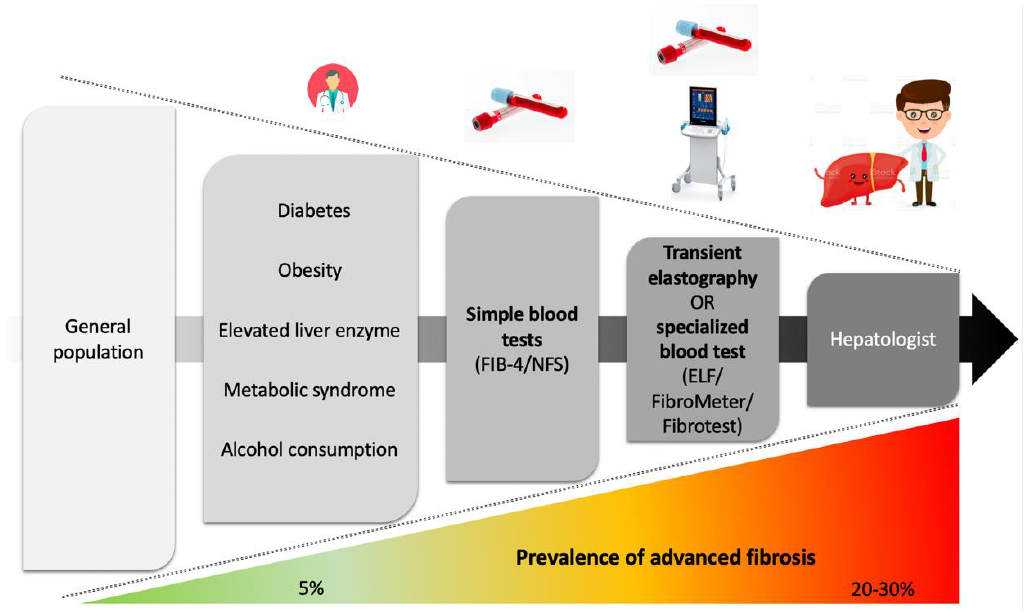
Figure 2. Proposed patient pathway in the general population.